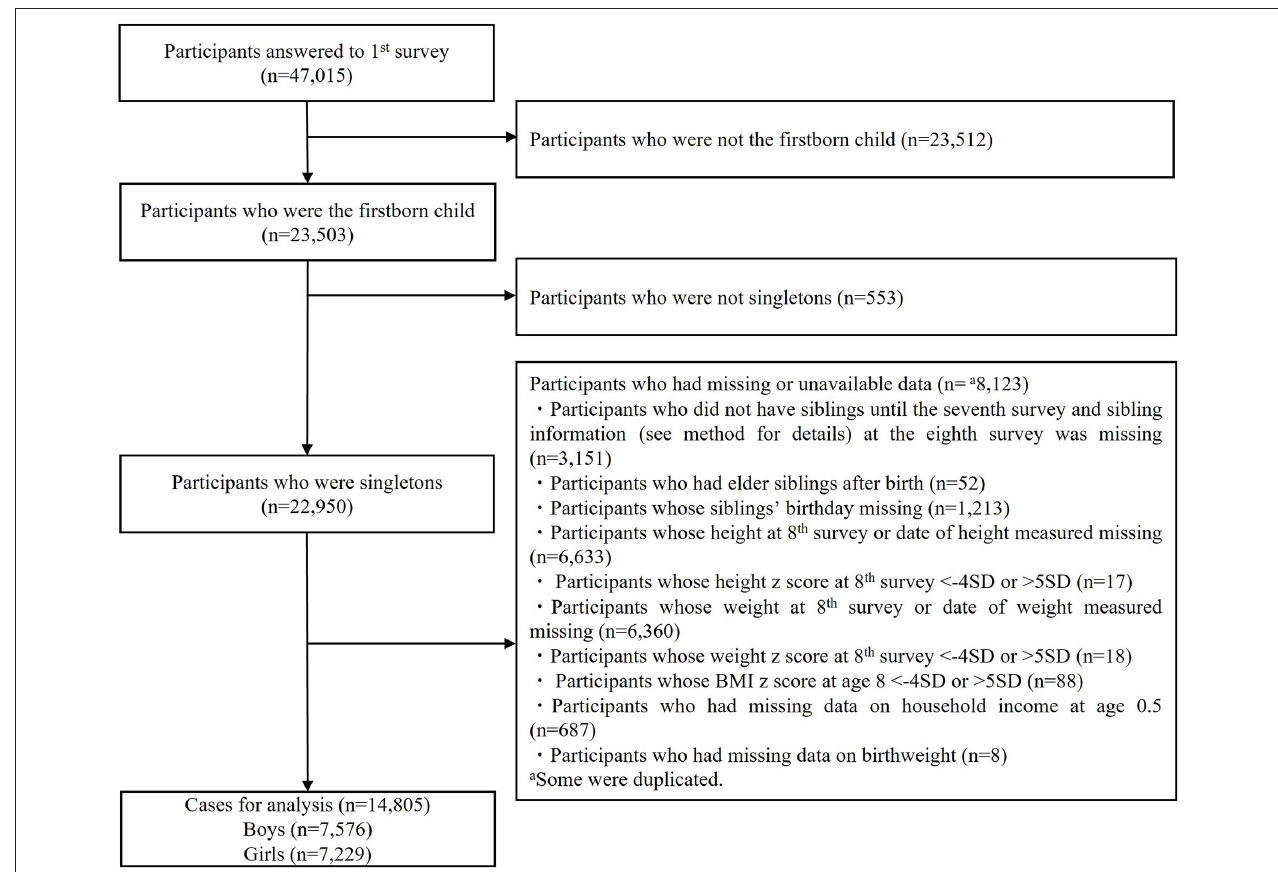
FIGURE 1 | Enrollment of study